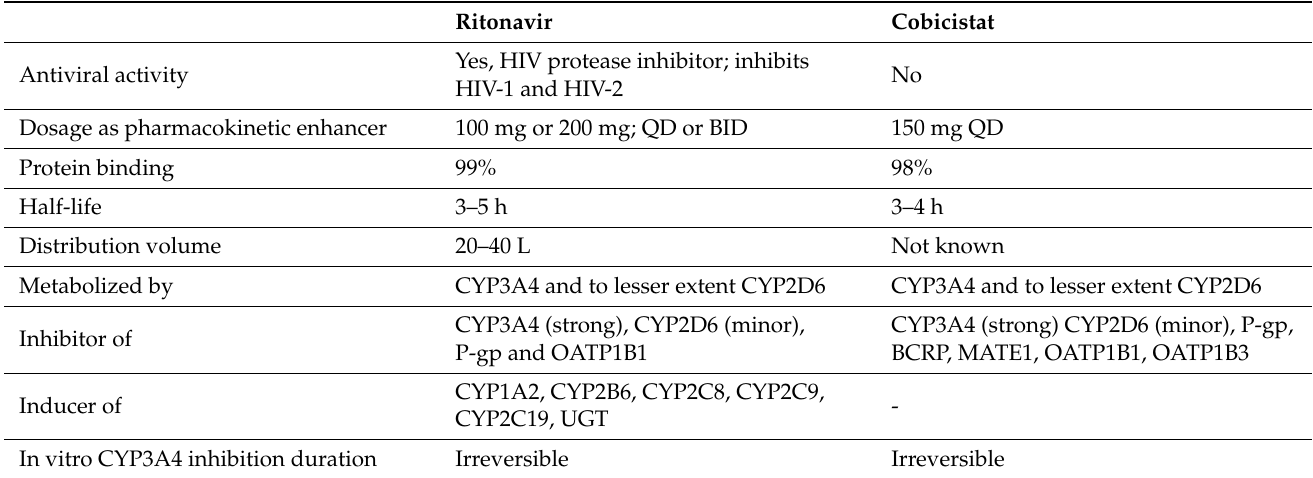
Table 2. Comparison of relevant drug properties of ritonavir and cobicistat. Relevant drug char- acteristics were retrieved from the Summary of Product Characteristics (SmPC), European Public Assessment Reports (EPAR) and UpToDate [14,15].